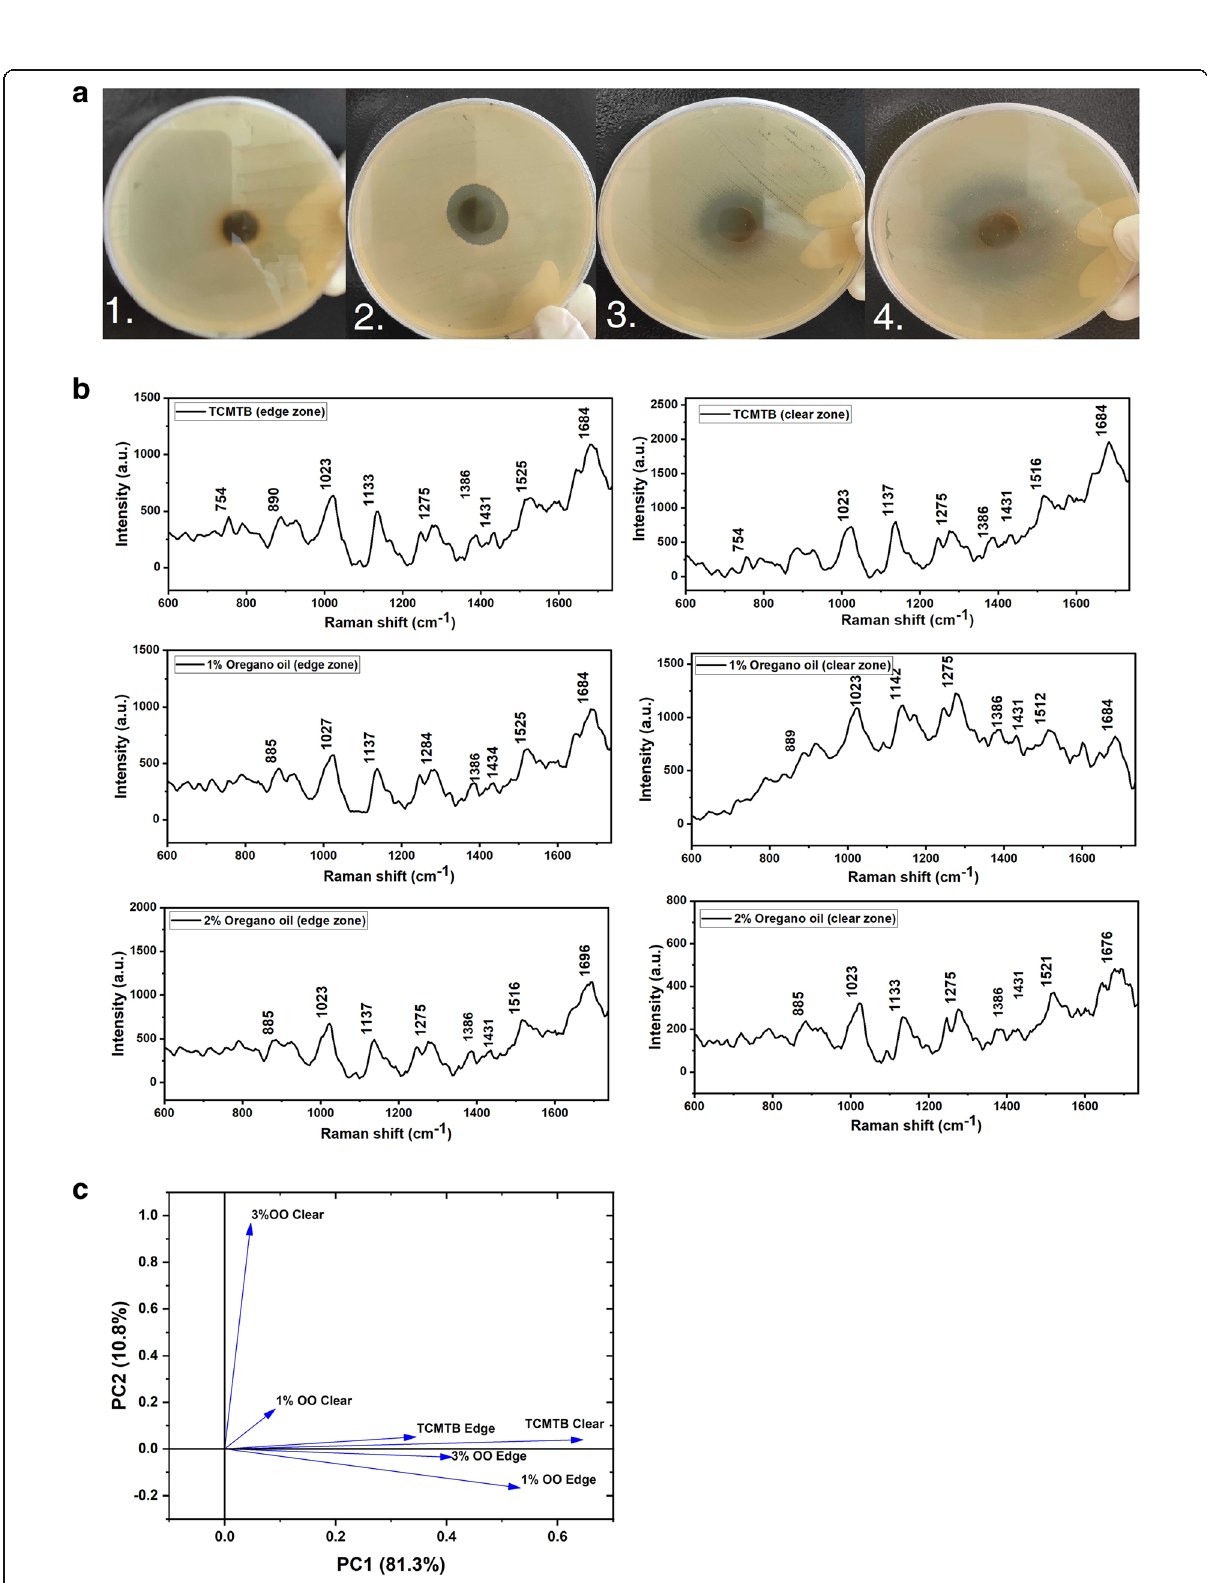
Fig. 9 a Leather samples treated (1) without any biocide, (2) with TCMTB, (3) 1% oregano oil and (4) 2% oregano oil during the processing b average Raman spectra from clear and outer edge zone of A. hydrophila grown in the presence of leather specimen inoculated with TCMTB, 1% oregano oil and 2% oregano oil; c PCA score plot of the mentioned